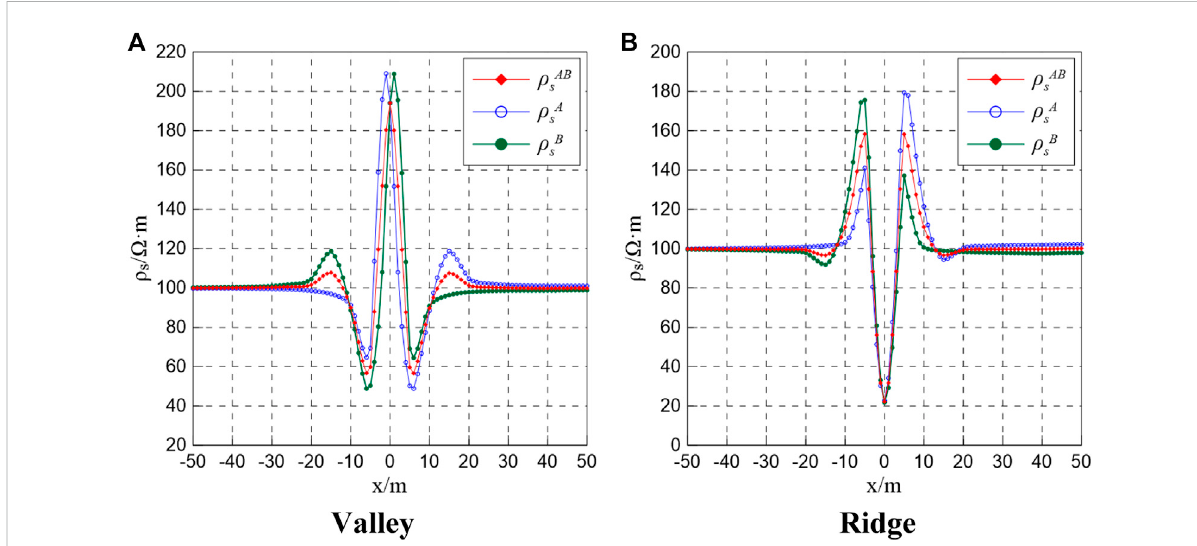
FIGURE 4 Line source pure terrain joint pro fi le anomaly curves for (A) valley and (B) ridge.